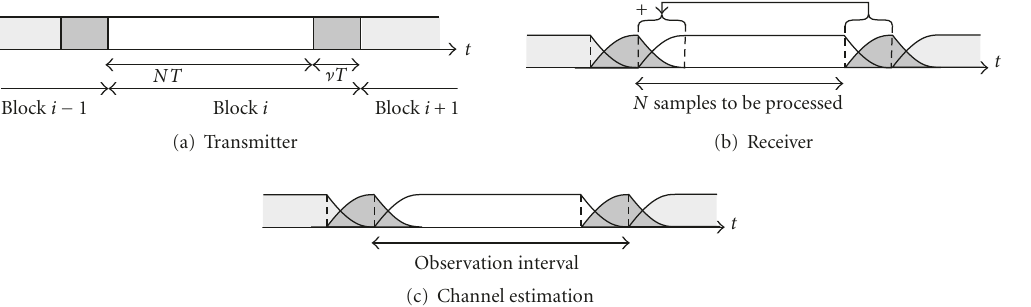
Figure 1: Time-domain signal of KSP-OFDM: (a) transmitted signal, (b) received signal and observation interval for data detection, and (c) observation interval for channel